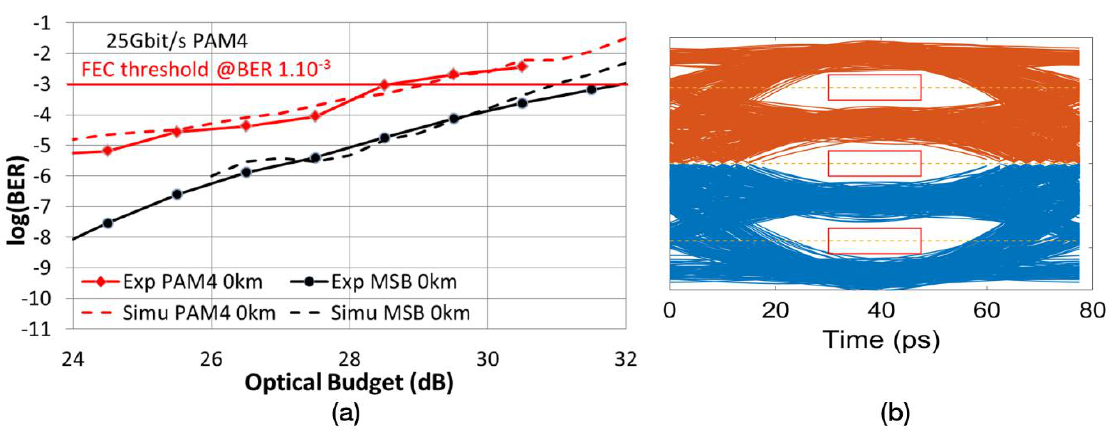
Figure 4. ( a ) Calibration of the simulation with experiment for PAM4 transmission in optical back to back at 25Gbit/s with a PRBS15; ( b ) Eye diagram with rectangular decision masks.